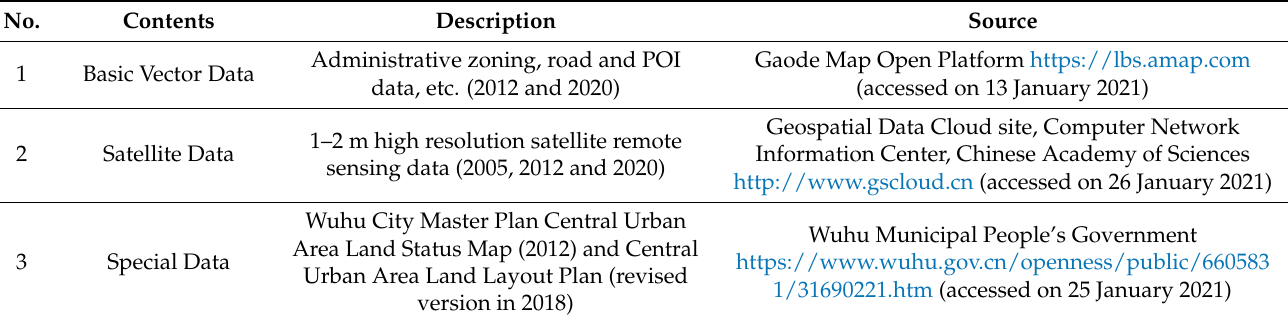
Table 2. List of basic geographic information